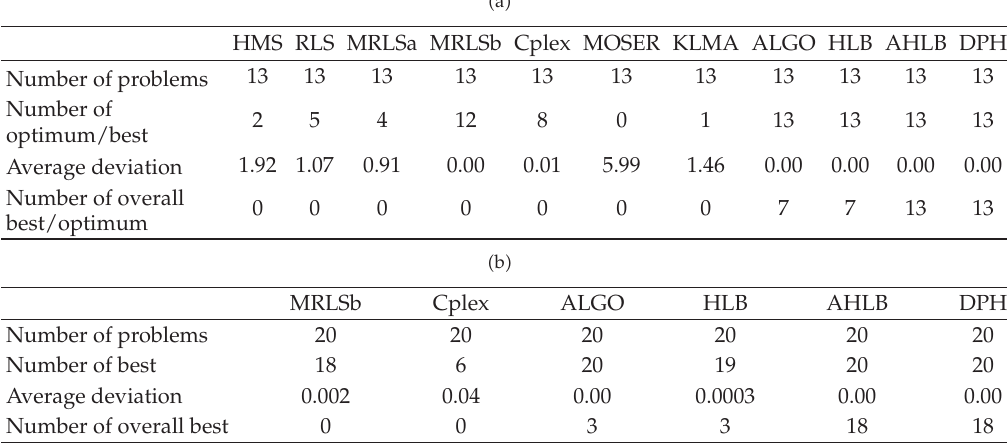
Table 3: (cid:2) a (cid:3) Summarized results for the solution quality of group 1 problem. (cid:2) b (cid:3) Summarized results forthe solution quality of group 2